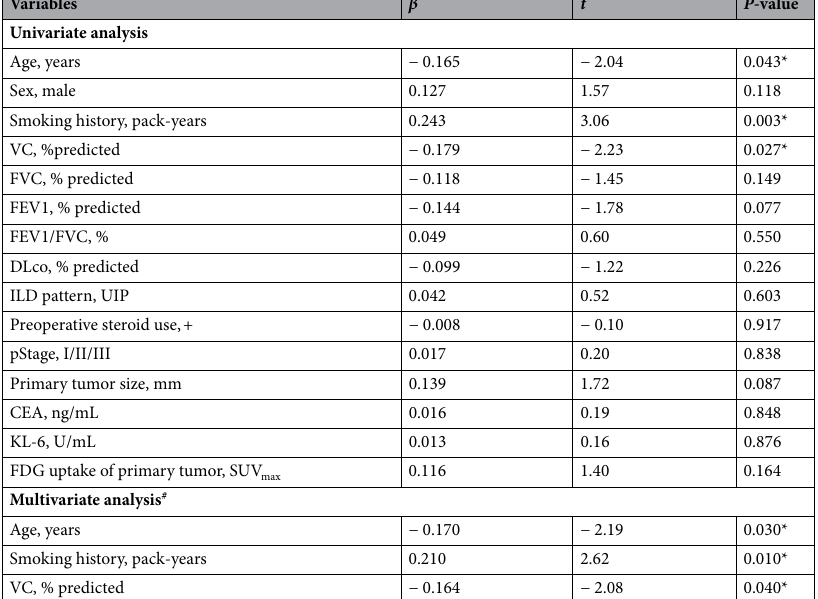
Table 2. Linear regression analysis to elucidate the factors associated with preoperative levels of serum HMGB1. AE-ILD acute exacerbation; CEA carcinoembryonic antigen; DLco diffusing capacity for